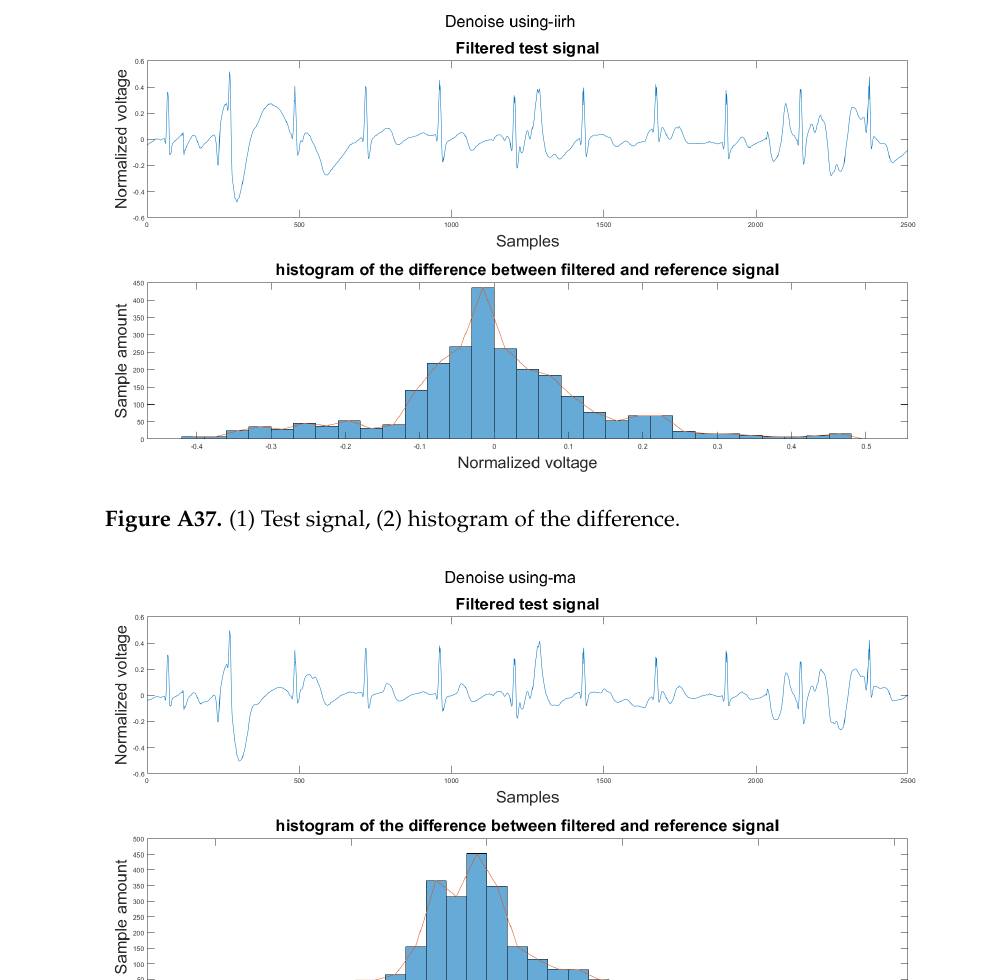
Figure A36. (1) Test signal, (2) histogram of the difference.